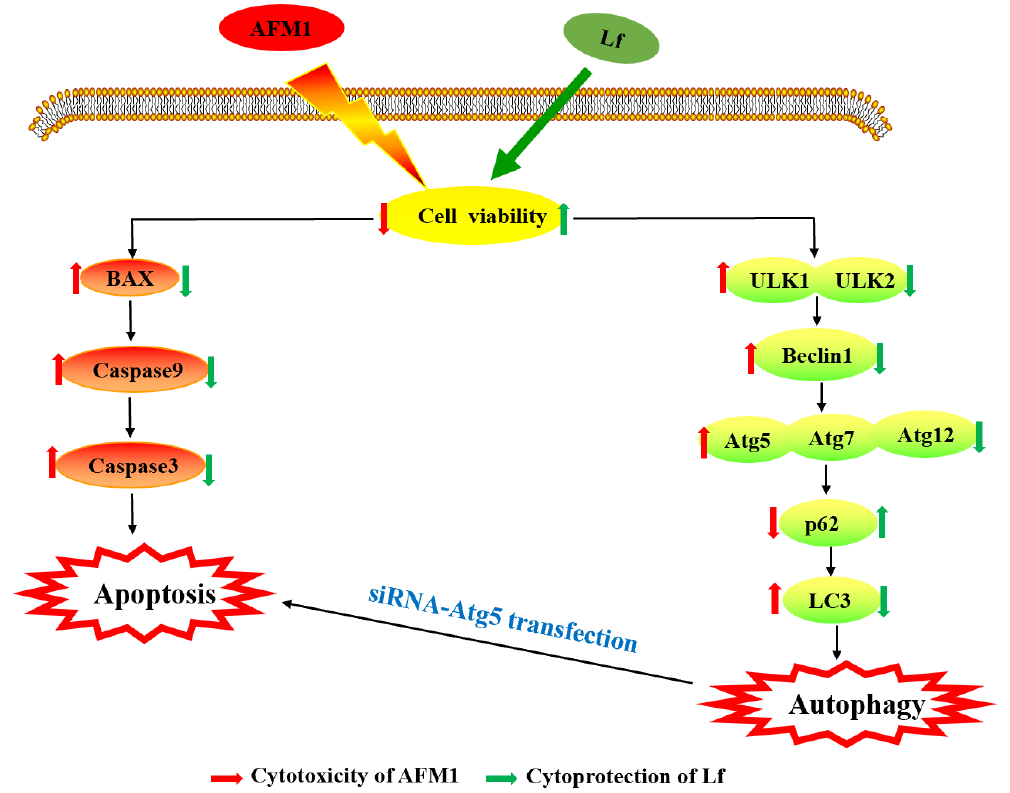
Figure 5. Summary diagram showing the cytotoxicity induced by AFM1, and the cytoprotective effect of Lf in NCM460 cells.